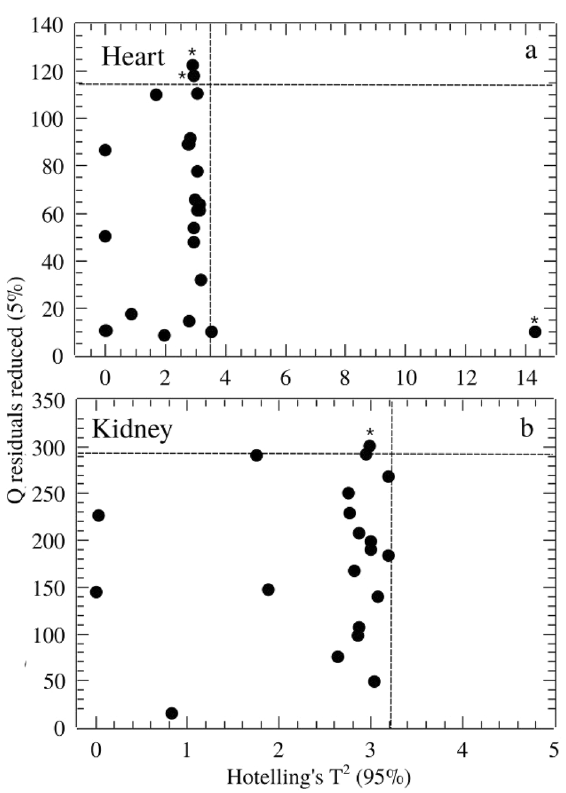
Figure 2. Outliers identification by inspection of Q residuals (reduced) versus Hotelling’s T 2 plot for for heart ( a ) and kidney ( b ) groups. Outliers were indicated by “*”. Dashed lines horizontal and vertical lines represents confidence limit of 95% (Hotelling’s T 2 ) and 5% (Q residuals),